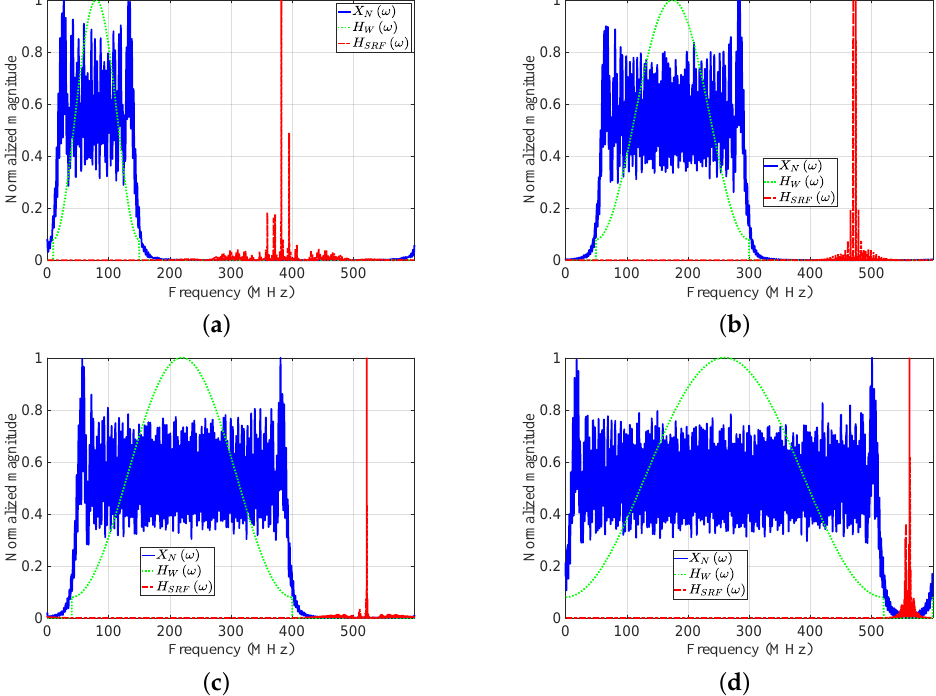
Figure 16. The frequency response Xr N ( ω ) , H W ( ω ) , and H SRF ( ω ) : ( a ) case 1, ( b ) case 2, ( c ) case 3, ( d ) case